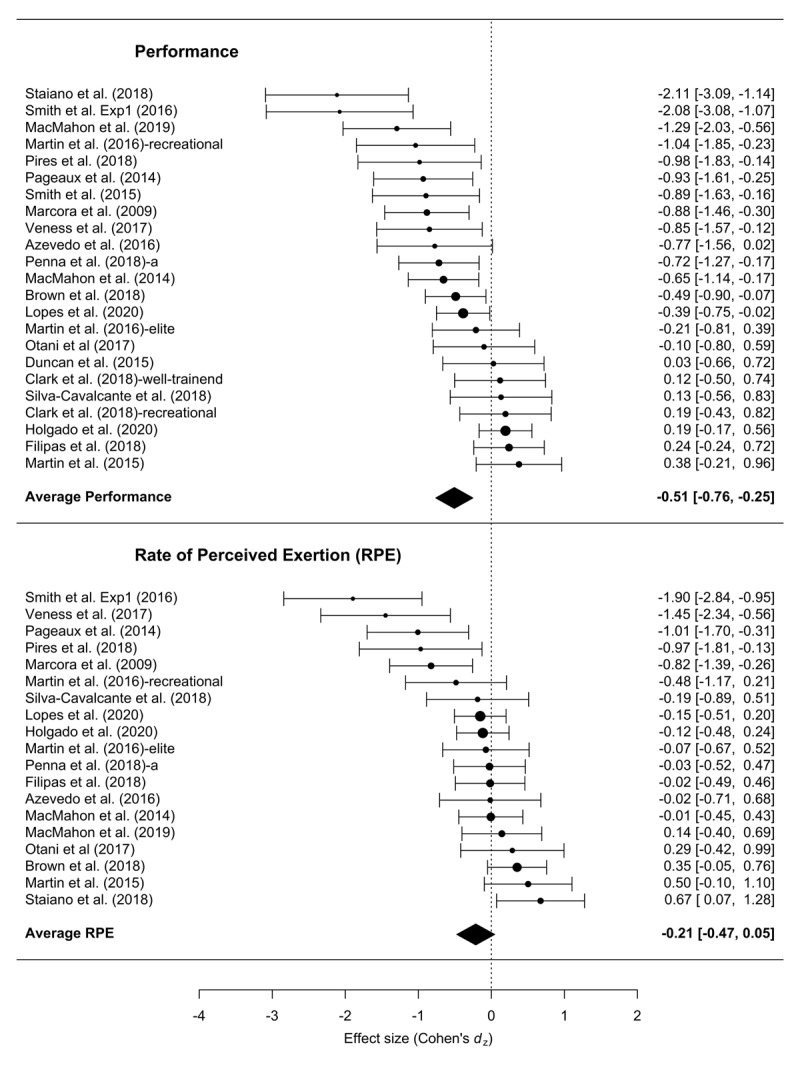
Forest plot of the effect size of mental fatigue on exercise performance and RPE.